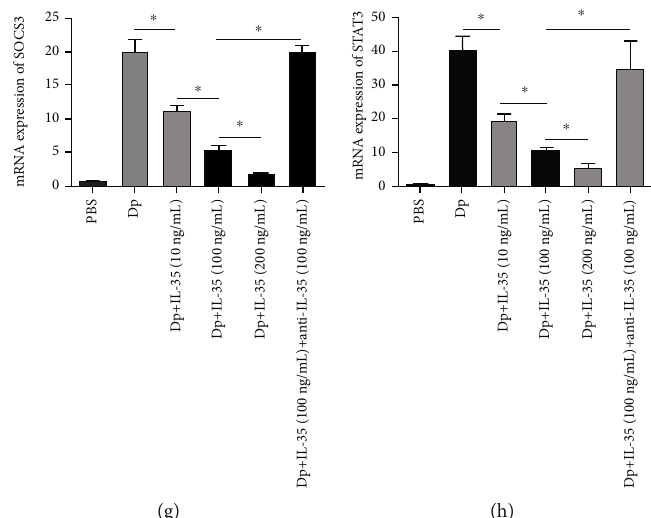
Figure 4: E ff ect of IL-35 of HNECs in allergic mice. (a – c) The protein expression of IL-25, IL-33, and TSLP by nasal lavage fl uid in allergic mice. (d – f) The protein expression of eotaxin-1, eotaxin-2, and eotaxin-3 by nasal lavage fl uid in allergic mice. (g, h) The mRNA expression of SOCS3 and STAT3 by nasal mucosa tissue in allergic mice. ∗ Compared between groups, P < 0 : 05 . Three independent tests were performed for every